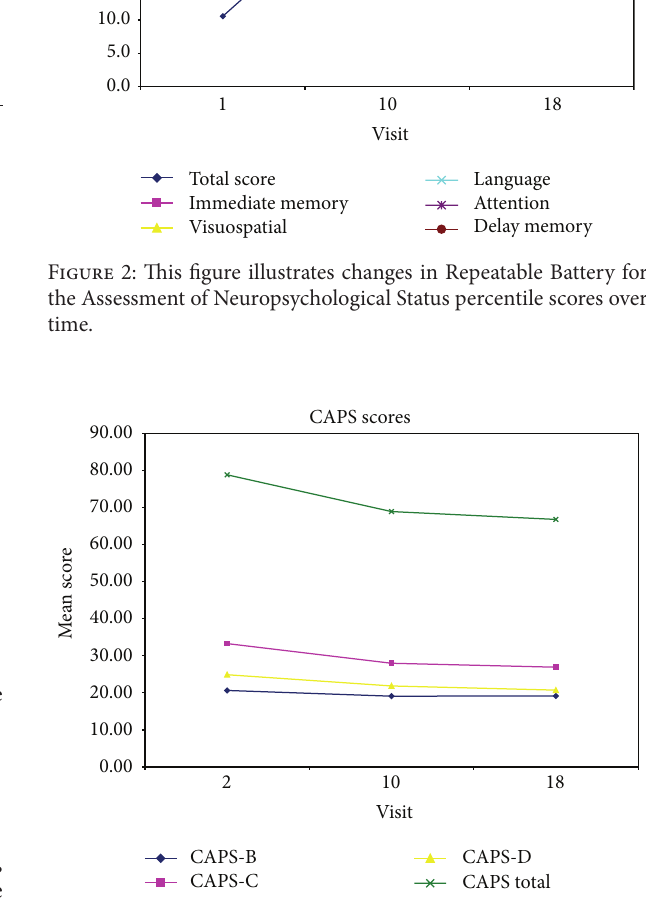
Figure 3: This figure illustrates changes in Clinician Administered PTSD Scale scores over